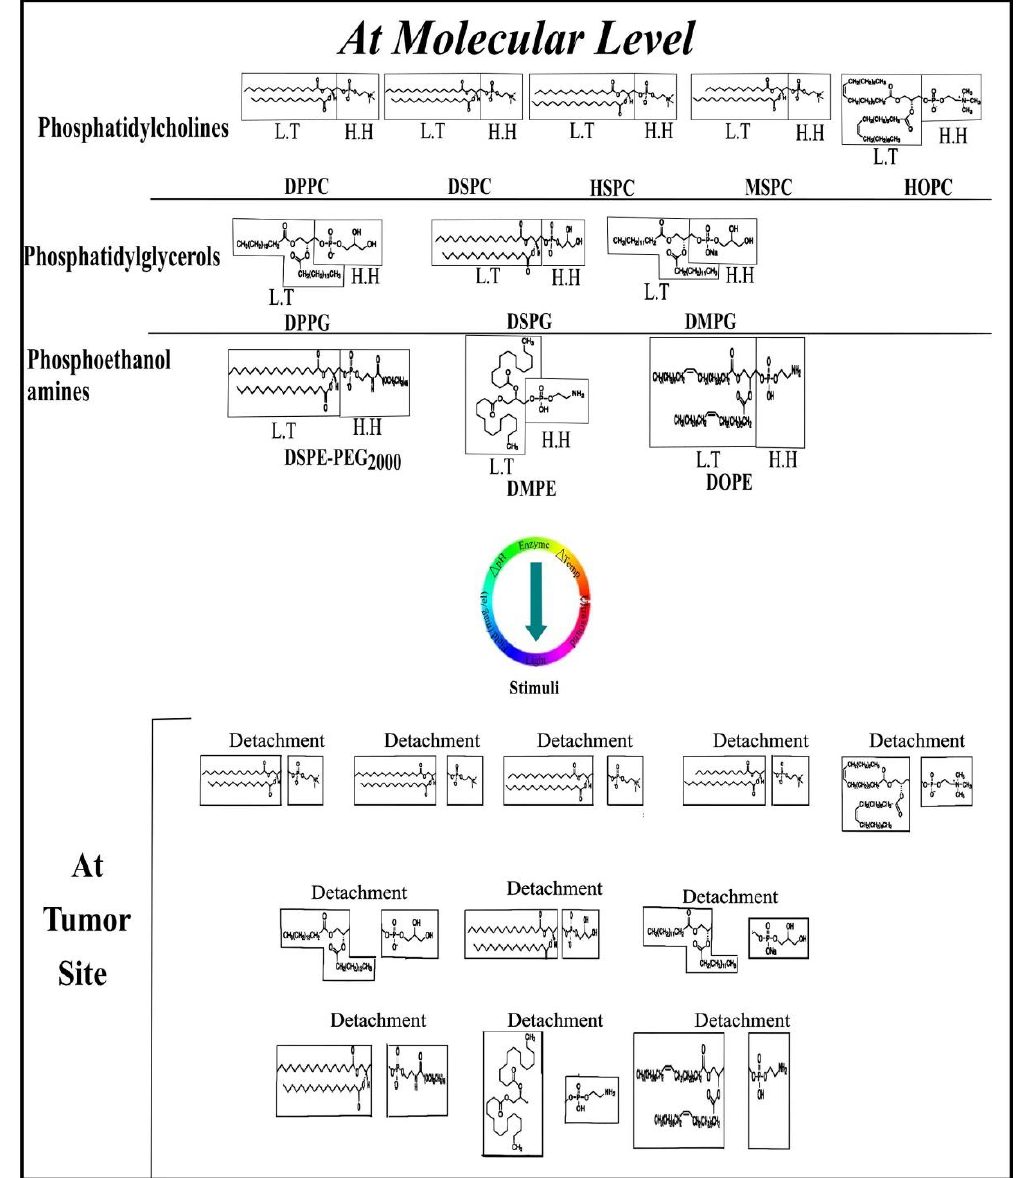
Figure 3. Molecular Transitions in Stimuli-Responsive Lipid-based Drug Delivery Systems used for Cancer Chemotherapy (“L.T” represents Lipophilic Tail, “H.H” represents Hydrophilic Head, “DPPC” represents 1,2-dipalmitoyl-sn-glycero-3-phosphocholine, “DSPC” represents 1,2-distearoyl-sn-glycero-3-phosphocholine, “HSPC” represents hydrogenated soy phosphatidylcholine, “MSPC” represents 1-myristoyl-2-stearoyl-sn-glycero-3-phosphocholine, “HOPC” represents 1-hexadecenyl-2-oleoyl-sn-glycero-3-phosphocholine, “DPPG” represents 1,2-dipalmitoyl-sn-glycero-3-phosphatidylglycerol, “DSPG” represents 1,2-distearoyl-sn-glycero-3-phosphatidylglycerol, “DMPG” represents 1,2-dimyristoyl-sn-glycero-3-phosphatidylglycerol, “DSPE-PEG 2000 ” represents 1,2-distearoyl-sn-glycero-3-phosphoethanolamine-N-[amino (polyethylene glycol)-2000], “DMPE” represents 1,2-dimyristoyl-sn-glycero-3-phosphoethanolamine, “DOPE” represents 1,2-dioleoyl-sn-glycero-3-phosphoethanolamine).